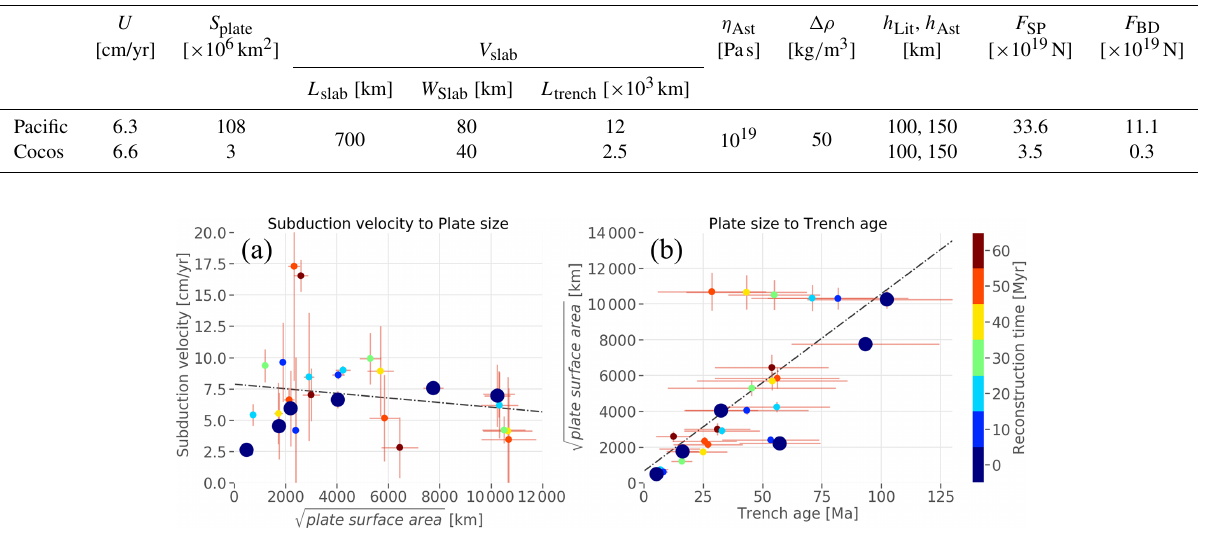
Table 1. Slab pull and basal-drag force calculations, with associated parameters, for the Pacific and Cocos plates. U is subduction velocity, S plate is subducting plate surface area, V slab is the slab volume, L slab is the length of the slab in the upper mantle, W Slab is the thickness of the slab, contributing to the difference in buoyancy due to slab age, L trench is the length of subduction trench, η Ast is the viscosity of the asthenosphere, (cid:49)ρ is the density difference between the slab and surrounding mantle, and h Lit and h Ast are the thickness of the lithosphere and asthenosphere. F SP and F BD are the slab pull and basal-drag forces, calculated using Eqs. (1) and (2).